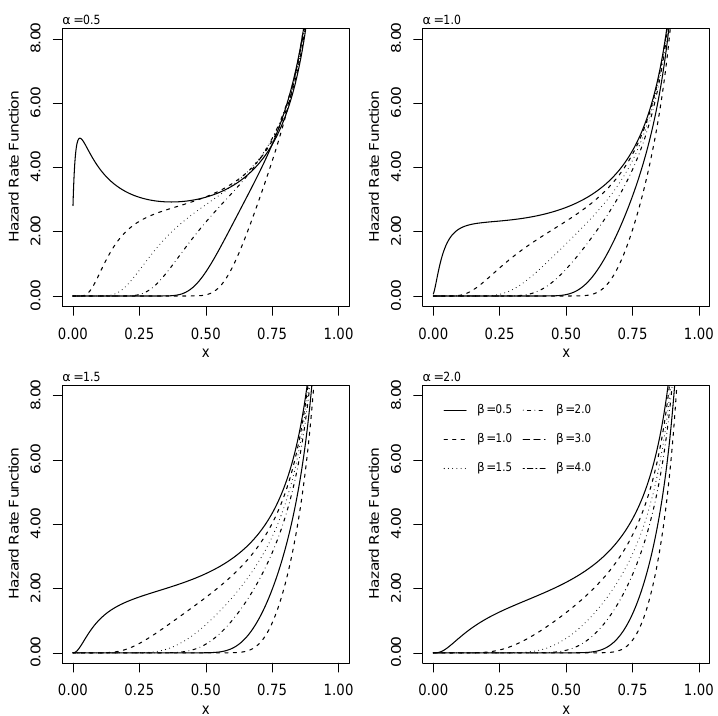
Figure 2 – Hazard rate plots of the unit-Gompertz distribution considering different values of α and β